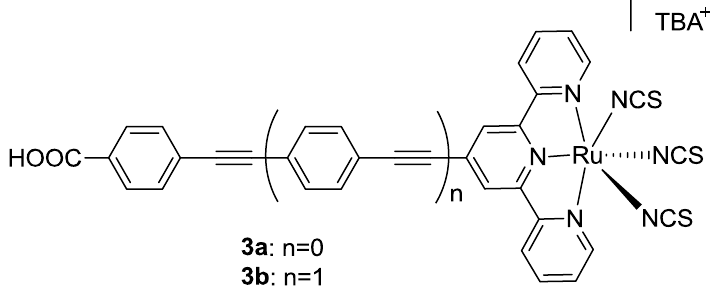
Figure 5. Complexes reported by Funaki et al. [72].